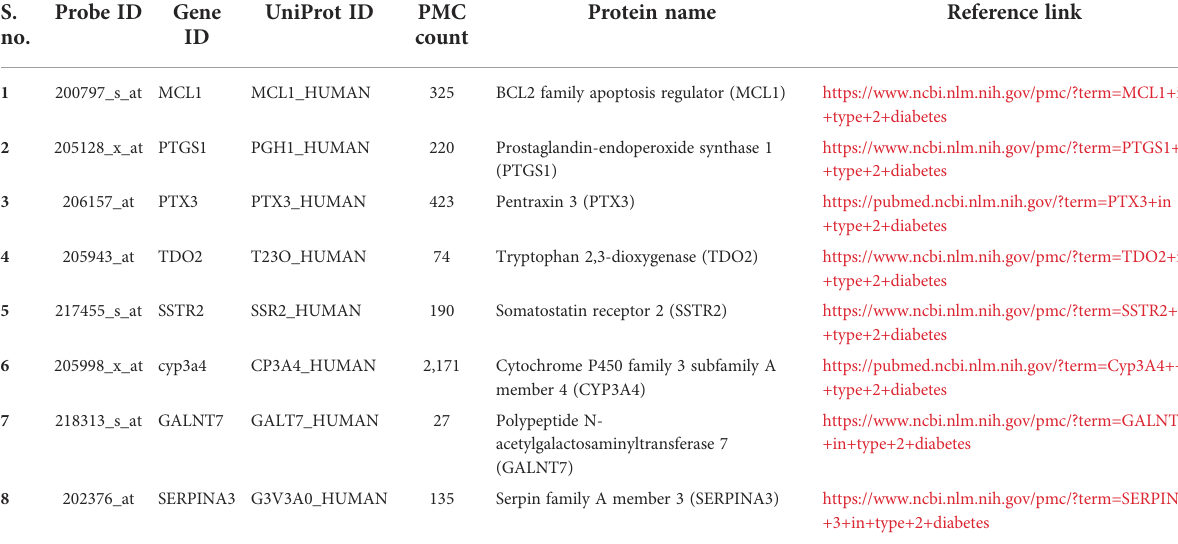
TABLE 2 List of differentially expressed type 2 diabetes-related signature genes after curation.